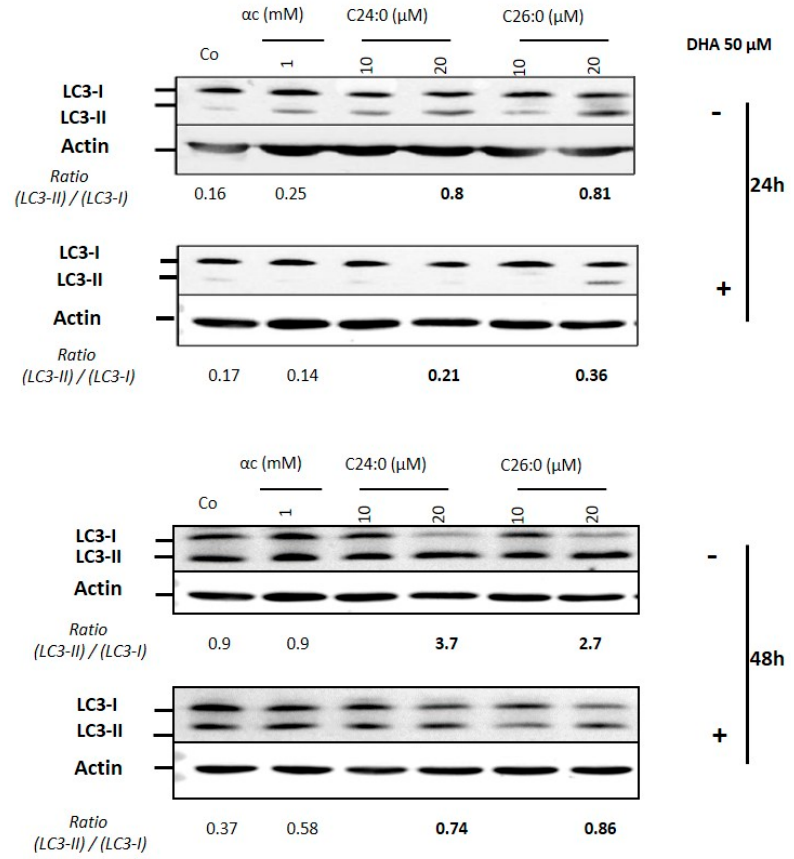
Figure 2. Effects of DHA on VLCFA (C24:0 or C26:0)-induced autophagy on 158N murine oligodendrocytes. Murine oligodendrocytes were cultured with C24:0 or C26:0 at 10 or 20 µ M in presence or absence of 50 µ M DHA for 24 and 48 h. Autophagy was evaluated by Western blotting, detecting the conversion of LC3-I to LCC3-II.